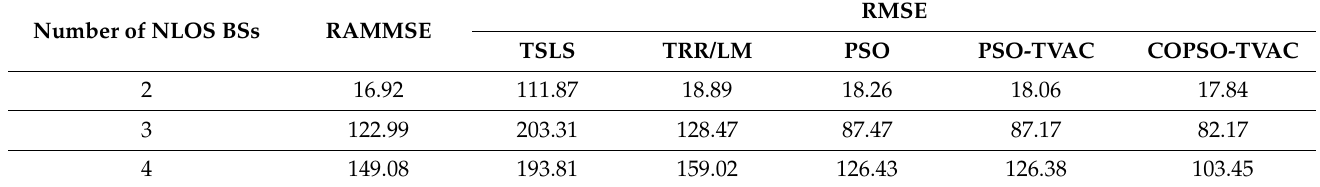
Table 3. Location accuracy for the considered algorithm [m], the urban environment.